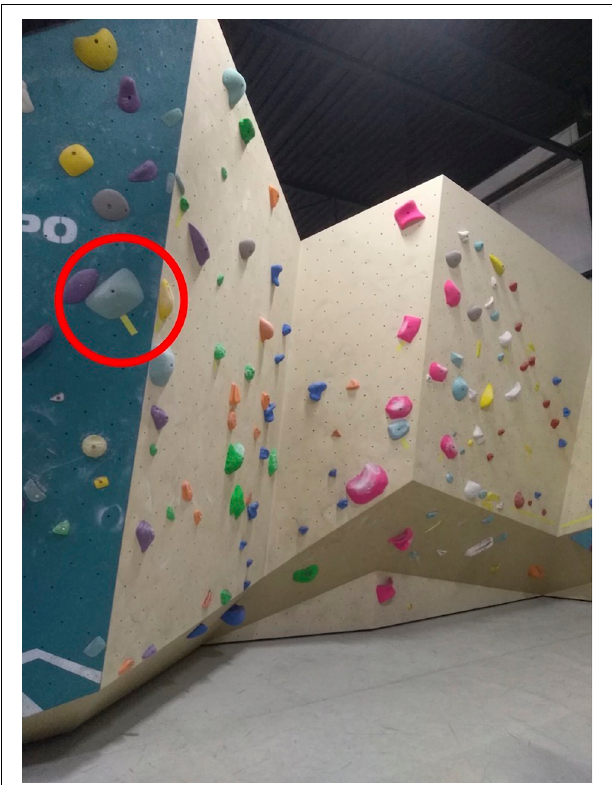
FIGURE 2 | Photograph of the experimental setup with most of the included routes. The zone holds were marked with yellow stripes for the athletes’ clarity (an example is marked with the red circle). Consecutive holds of the same coloration yield one route.